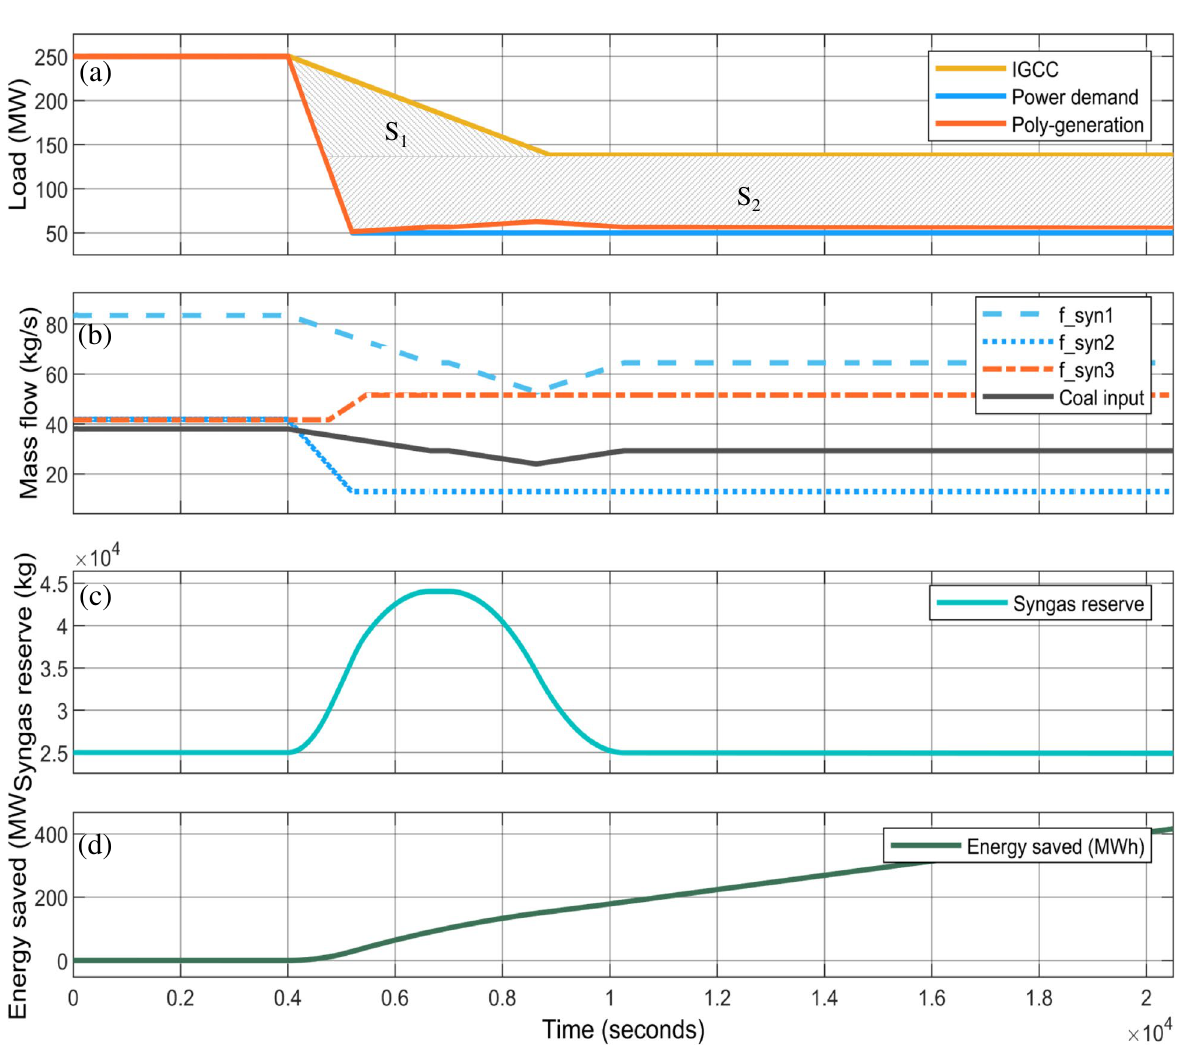
Fig. 5 Key parameters of each system during the peak regulation process ( a the power output of each system; b the mass flow of coal input and syngas flow in the poly-generation system; c the syngas reserves of the tank; d the energy saved in renewable energy of the new system versus the IGCC system)